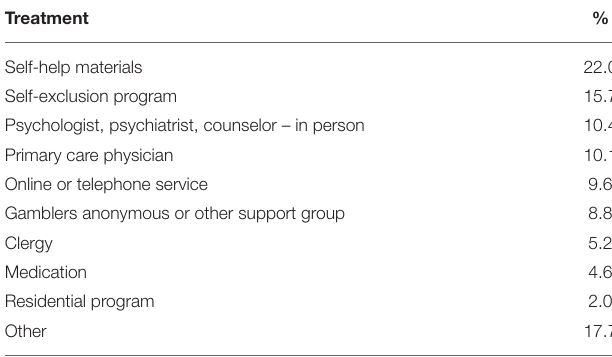
TABLE 2 | Individuals with gambling problems attempting self- change or treatment-assisted change.